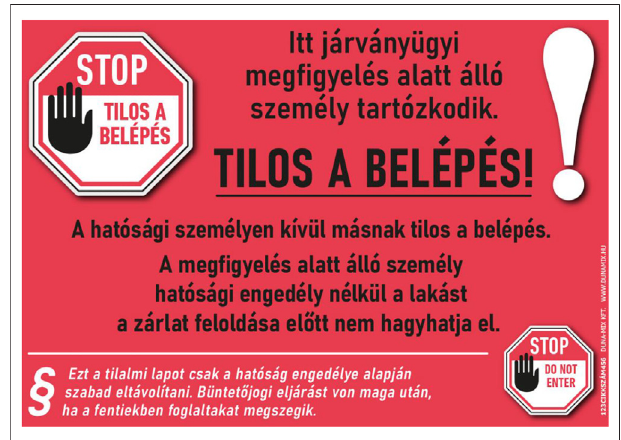
FIGURE2 | Sticker placed on building doors in Hungary.The red sticker states that it is prohibited to enter, as a person under the surveillance of